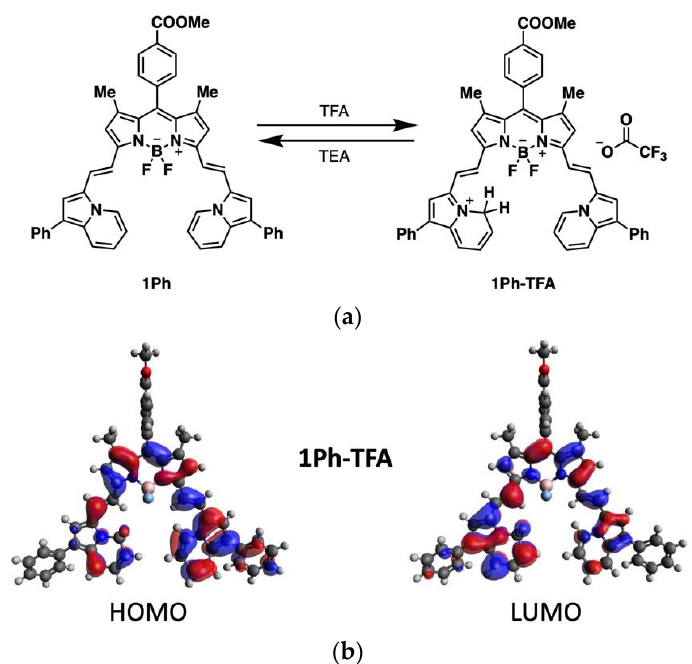
Figure 4. ( a ) Transformation of 1Ph after treatment with TFA with a plausible structure of protonated dye 1Ph-TFA ; ( b ) HOMO (left) and LUMO (right) orbitals for 1Ph-TFA in ( a ).